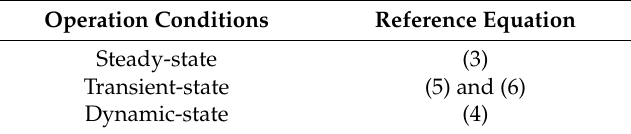
Table 2. Operation Table 2. Operation conditions.